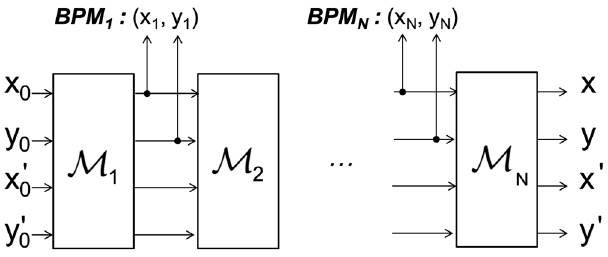
FIG. 1. Multioutput deep TM-PNN for particle